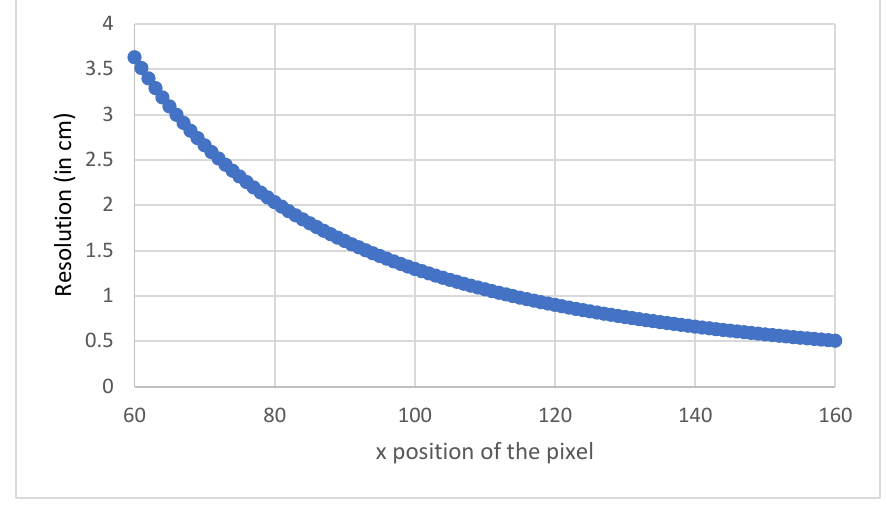
Figure 5. Variation of the resolution δD with x.